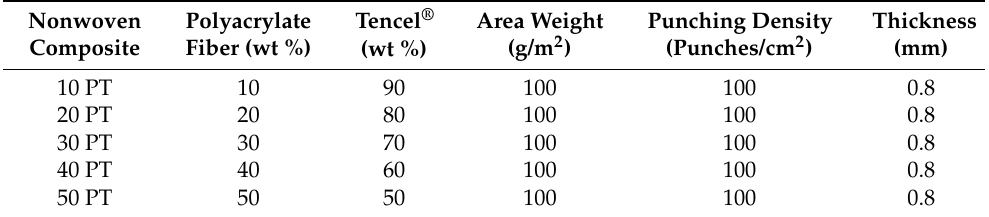
Table 1. Denotations of PT nonwoven composites used for blood absorption